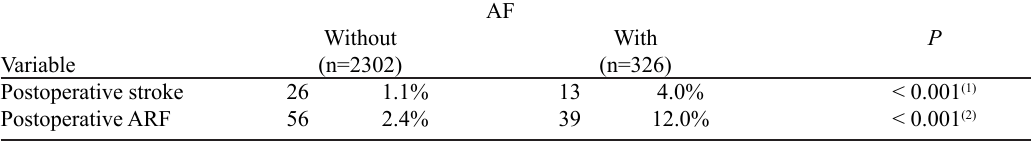
Table 3. Incidence values of Stroke and ARF in the postoperative